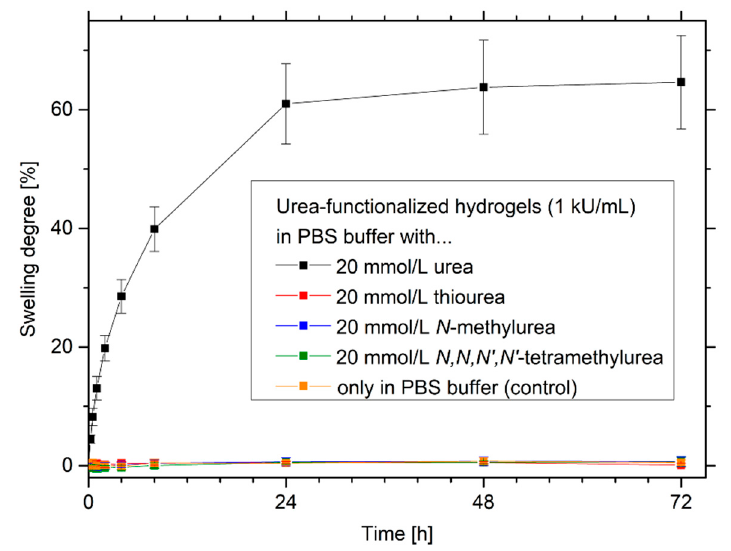
Figure 6. Substrate specificity of urease-functionalized poly(AAc- co -DMAEMA) hydrogels, tested via swelling kinetics in urea, thiourea, N -methylurea and N,N,N’,N’ -tetramethylurea.